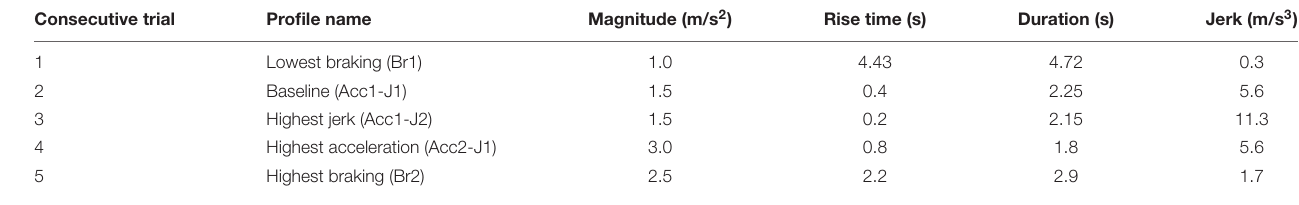
TABLE 3 | Main characteristics of the perturbation profiles